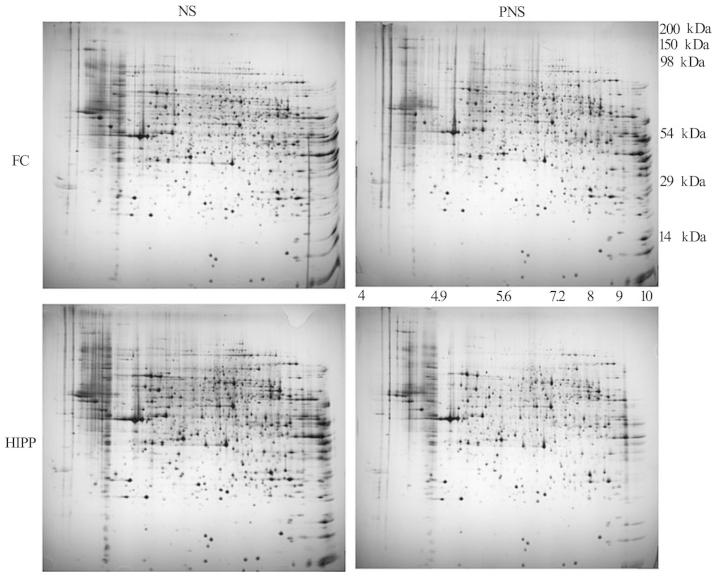
Protein profiles of two-dimensional gel electrophoresis. FC, prefrontal cortex; Hipp, hippocampus; NS, non-prenatal stressed offspring; PNS, prenatal stressed offspring.